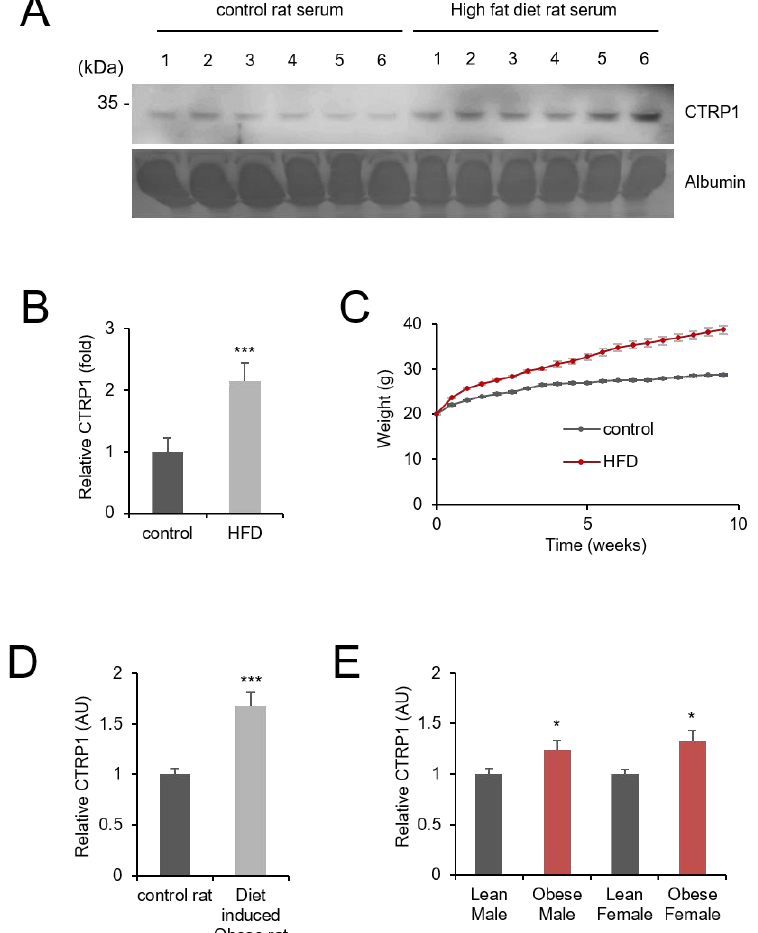
Figure 1. CTRP1 serum level is elevated in obesity. ( A ) The protein level of CTRP1 in serum is increased in high-fat diet mice. Mice were fed with a control diet or a high-fat diet for 10 weeks. After feeding, an equal amount of mouse blood serum was subject to Western blotting with anti-CTRP1 antibody (upper panel). Albumin was visualized by Ponceau S staining (bottom panel). Images of the uncropped western blots can be found in Figure S1. ( B ) The level of CTRP1 protein was quantified and depicted in the graph. The graph shows the average and standard error. Control vs high-fat diet rat, *** p < 0.005 ( n = 6). ( C ) The weights of the mice are shown in the graph. ( D ) GEO data analysis shows an elevated level of CTRP1 mRNA in obese rats. GEO data were used for analysis. ( E ) GEO data shows that the level of CTRP1 mRNA is elevated in obese humans (abdominal subcutaneous adipocytes), * p <